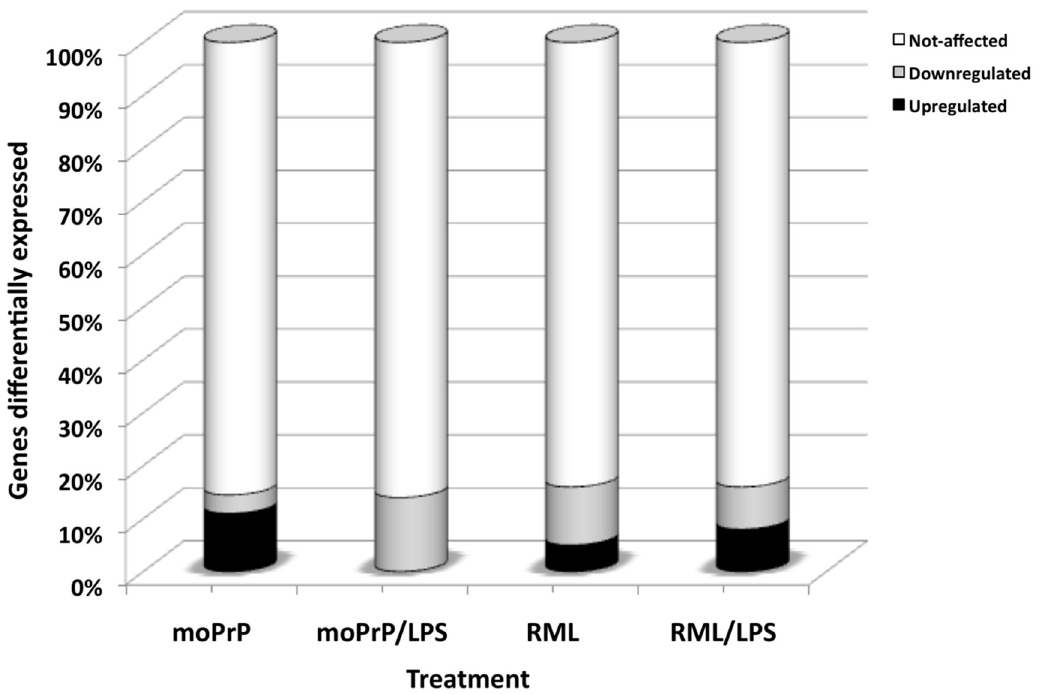
Figure 1. Genes differentially expressed in the brain of mice terminally sick that were euthanized after treatment with: (1) resistant mouse recombinant prion protein (moPrP res ); (2) moPrP res and lipopolysaccharide (LPS) from Escherichia coli 0111:B4; (3) Rocky mountain Lab brain homogenate (RML); (4) combination of RML and LPS. Table 1. List of differentially expressed genes in the brains of mice treated with LPS, moPrP res , moPrP res /LPS, RML/LPS, and RML at 11 weeks of